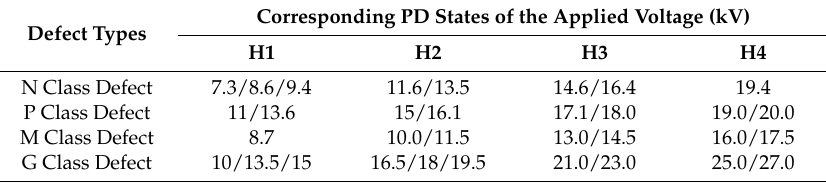
Table 5. Definition of the severity degrees of PD.